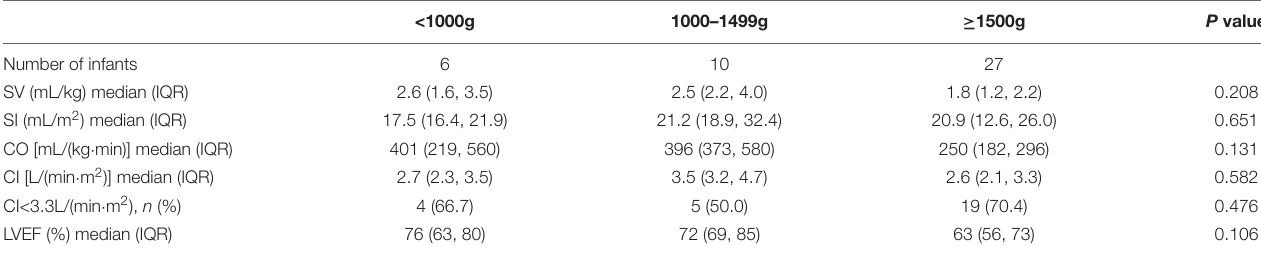
TABLE 3 | The baseline values of LV systolic functional parameters in preterm infants with septic shock at the different birth weight-stratified distribution.